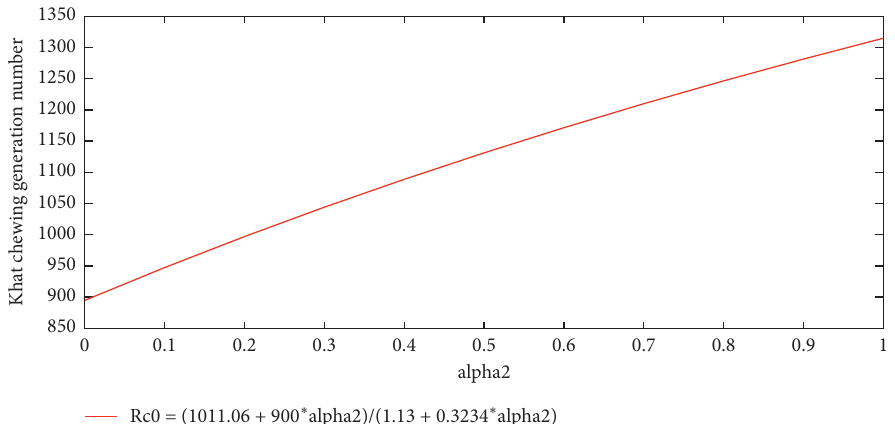
Figure 6: The Khat-chewing generation number increases as the value of α